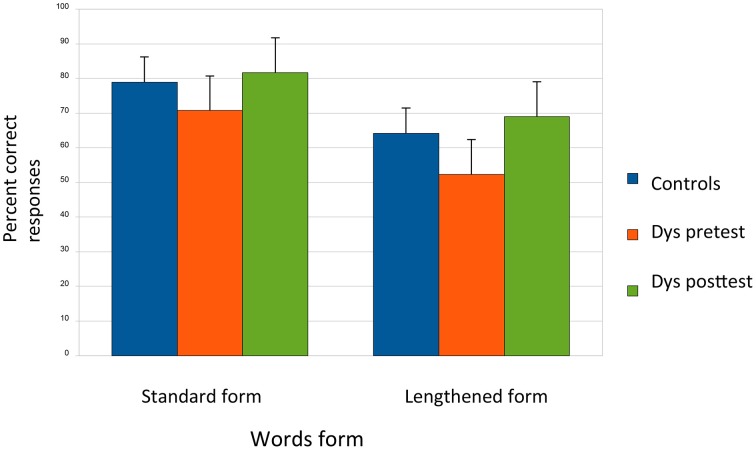
Syllabic duration task: before CMT, dyslexics (red) performed lower than controls (blue) for words with an unusual lengthening of the penultimate syllables. After the CMT program (green), the dyslexic's level of performance was higher for both type of words with stronger improvements for lengthened words.